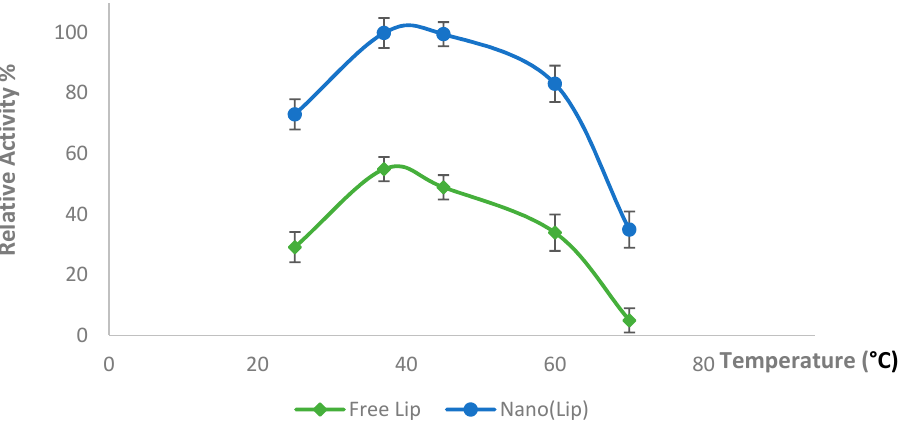
Figure 5. Temperature effect on the activity of free and Nano-LiP.